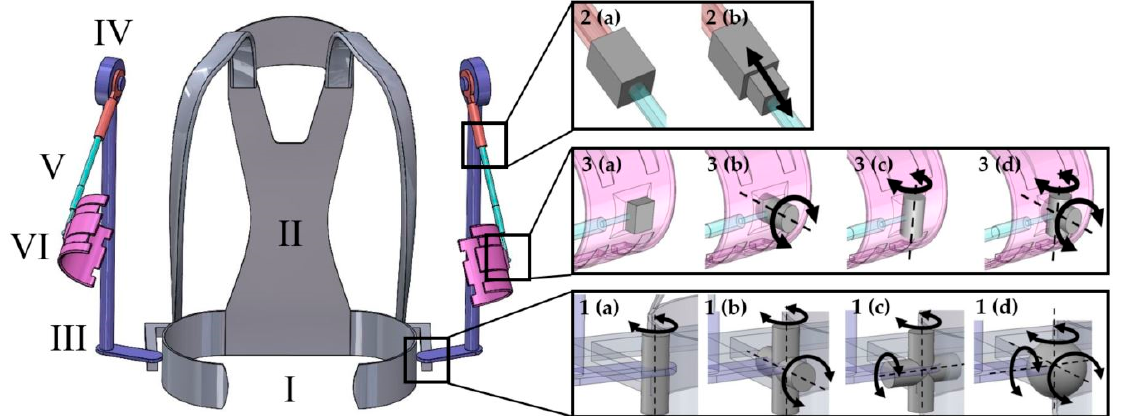
Figure 3. Model of the exoskeleton, including the hip belt (I, grey) and back plate (II, grey), the load ‐ bearing structures (III, violet) between the hip belt and torque ‐ generating joint (IV), the upper arm bracing (VI, pink), as well as the proximal (red) and distal (cyan) parts of a structure (V) connecting the torque ‐ generating joint and arm bracing. Black squares show the three possible joint positions per side. In the respective magnifications (black rectangles) the joint variants are illustrated: The hip connection (between grey and violet structures) can include a revolute joint (1 (a)), universal joints (1 (b), first axis: vertical axis or 1 (c), first axis: vertical axis)) or a spherical joint (1 (d)). The parts (red and cyan) of the structure between the torque ‐ generating joint and arm bracing can be con ‐ nected rigidly (2 (a)) or via a prismatic joint (2 (b)). The connection between the distal part of the structure and the arm bracing can be fixed (3 (a)), include two types of revolute joint (3 (b) and (c)) or a universal joint (3 (d), first axis: vertical axis). Grey blocks, cylinders, and spheres symbolize the respective joints. Additional axes (dotted lines) and black arrows indicate the possible axes of trans ‐ lation (2 (b)) or rotation.